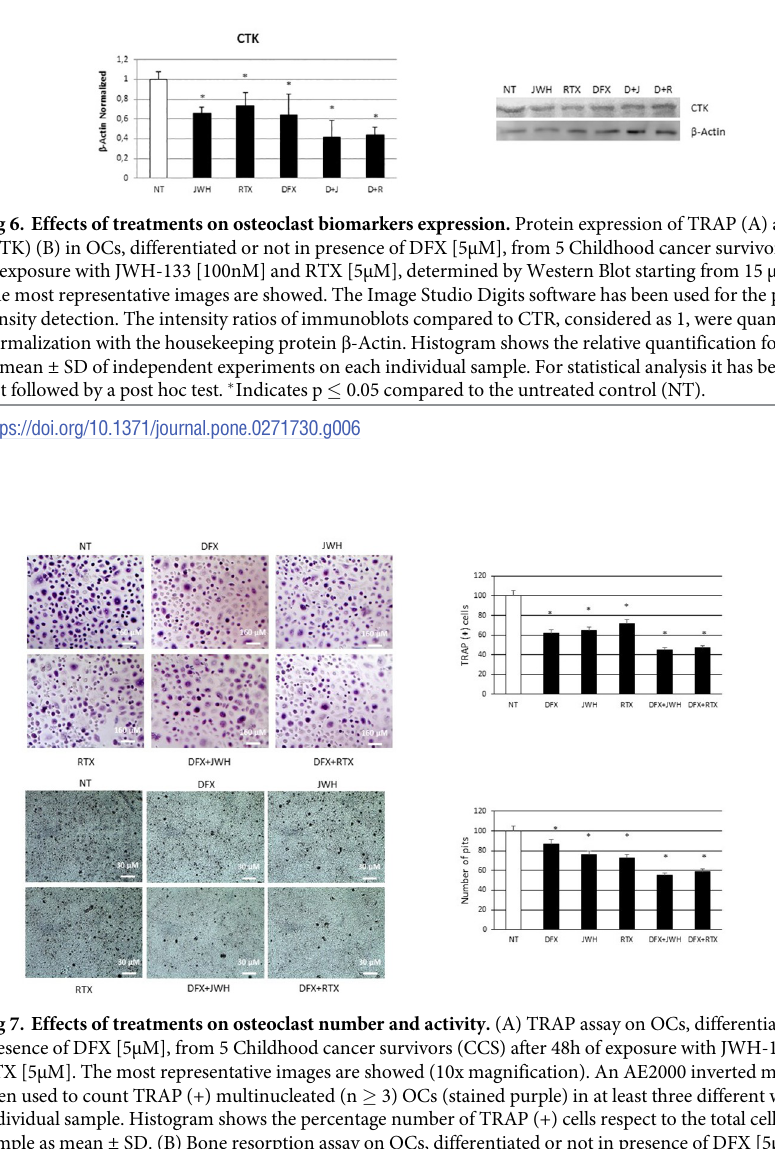
PLOS ONE | https://doi.org/10.1371/journal.pone.0271730 July 21, 2022 9 /